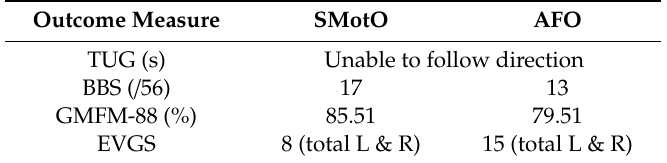
Table 4. Participant 3 outcome measure comparative results between SMotO and AFO.